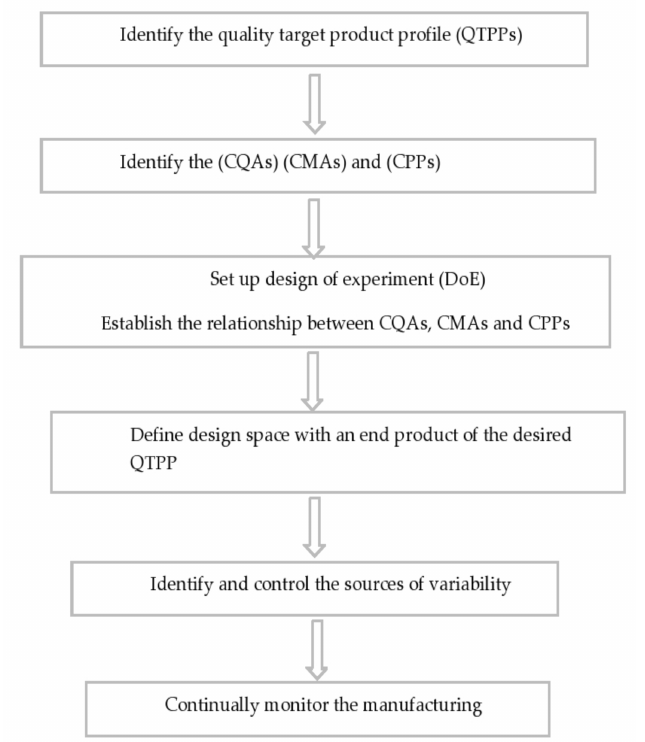
Figure 6. Schematic representation of steps involved in the pharmaceutical QbD